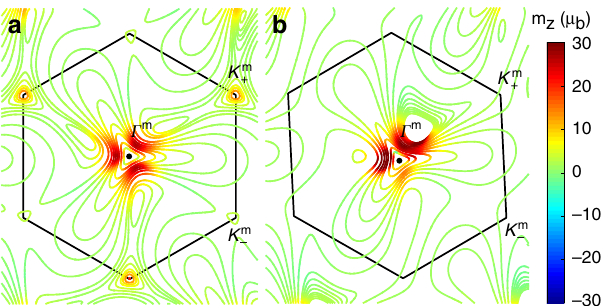
orbital magnetization in the Brillouin zone in the presence of strain is shown in Fig. 2b. The resultant magnetoelectric susceptibility can then be evaluated assuming the electron scattering time to be τ ¼ 10 ps 49 . For the conduction band ν ¼ c, the magnetoelectric susceptibility α ; α is shown in zx zy Fig. 3a as a function of the Fermi energy, where the Cartesian coordinate is set to have the x -axis along the angular bisector between the two zig-zag directions of the top and bottom graphene layers. The magnetoelectric susceptibility is maximized near the energy with the largest density of states. Interestingly, ; α α are still very large even when the density of states is very zx zy low. This is because the orbital magnetizations carried by the Bloch states near Γ m are very large as a result of the Berry curvatures of the fl at bands. This allows a large magnetization to be induced by a small current. As shown in the Supplementary Fig. 2, the current-induced orbital magnetization can be even stronger when strain is increased.